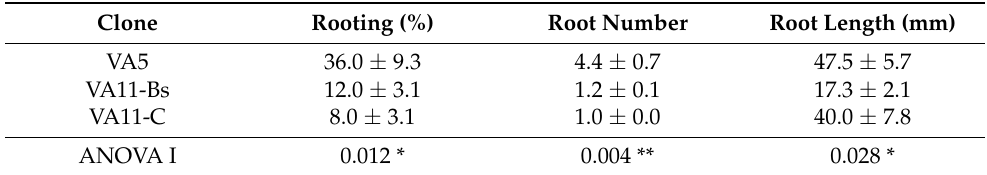
Table 4. Effect of 3 mg L − 1 IBA plus 0.1 mg L − 1 NAA added into the rooting medium on rooting rates of clones VA5, VA11-Bs, and VA11-C.